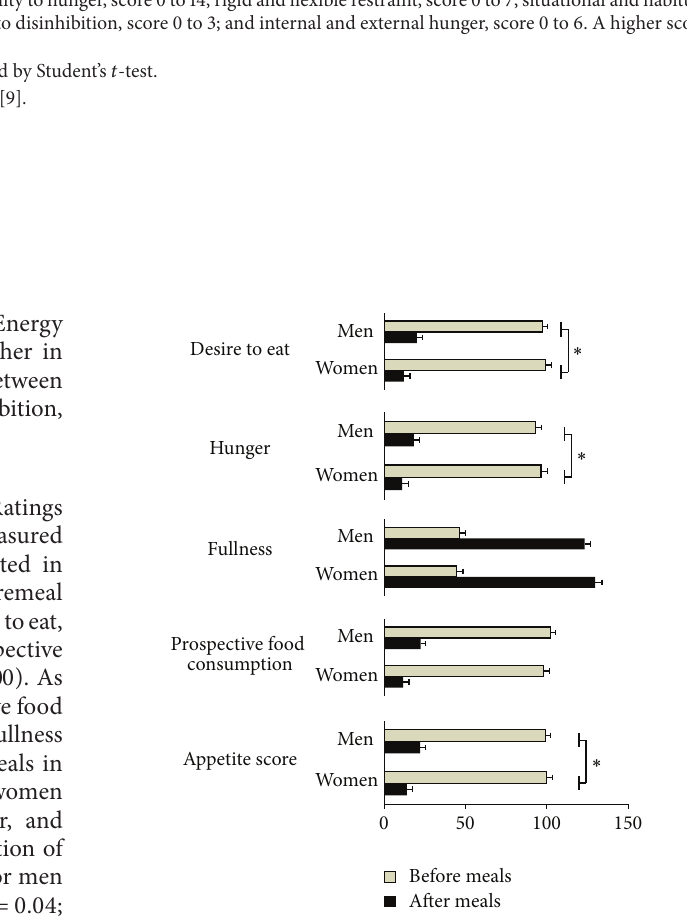
Figure 1: Appetite sensations before and after consumption of the Mediterranean meals during the fourth week of the feeding intervention. All data are provided as estimated means of all meals combined from the linear mixed-effects model with their standard errors. ∗ Women reported more decreases for their desire to eat, hunger, and appetite score in response to the consumption of the Mediterranean meals than men, 𝑃 < 0.05